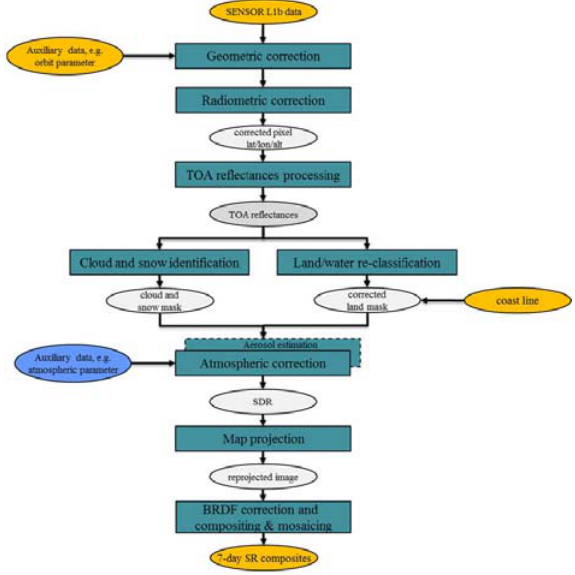
Figure 2. Schematic representation of the CCI-LC pre- processing chain (based on GlobAlbedo project, 2013) MERIS FR and RR global time series from 2003 to 2012